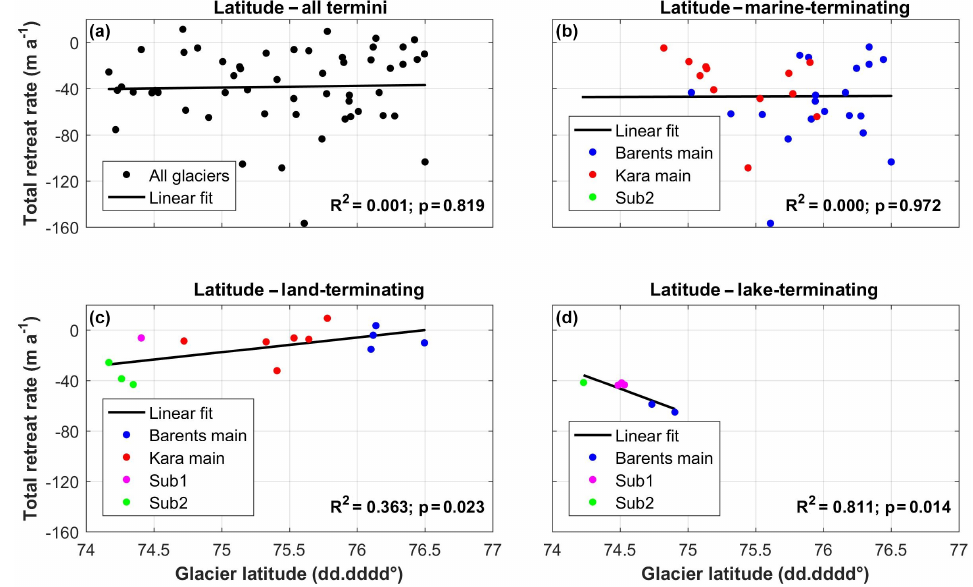
Figure 3. Linear regression of total retreat rate (1986–2015) versus glacier latitude. Latitude was regressed against total glacier retreat rate for (a) all outlet glaciers in the study sample; (b) marine-terminating glaciers only; (c) land-terminating glaciers only; and (d) lake-terminating glaciers only. In all cases, the linear regression line is shown, as are the associated R 2 and p values. The R 2 value indicates how well the line describes the data, and the p value indicates the significance of the regression coefficients, i.e. the likelihood that the predictor and response variable are unrelated. Table 2. Wilcoxon test results, used to assess significant differences in retreat rates between each manually identified time interval (1976– 1986, 1986–2000, 2000–2013, 2013, 2015). Retreat rate data were tested separately for each terminus type, and marine-terminating glaciers were further sub-divided by coast. Following convention, p values of < 0.05 are considered significant and are highlighted in bold. Barents Sea marine- Kara Sea marine- Land-